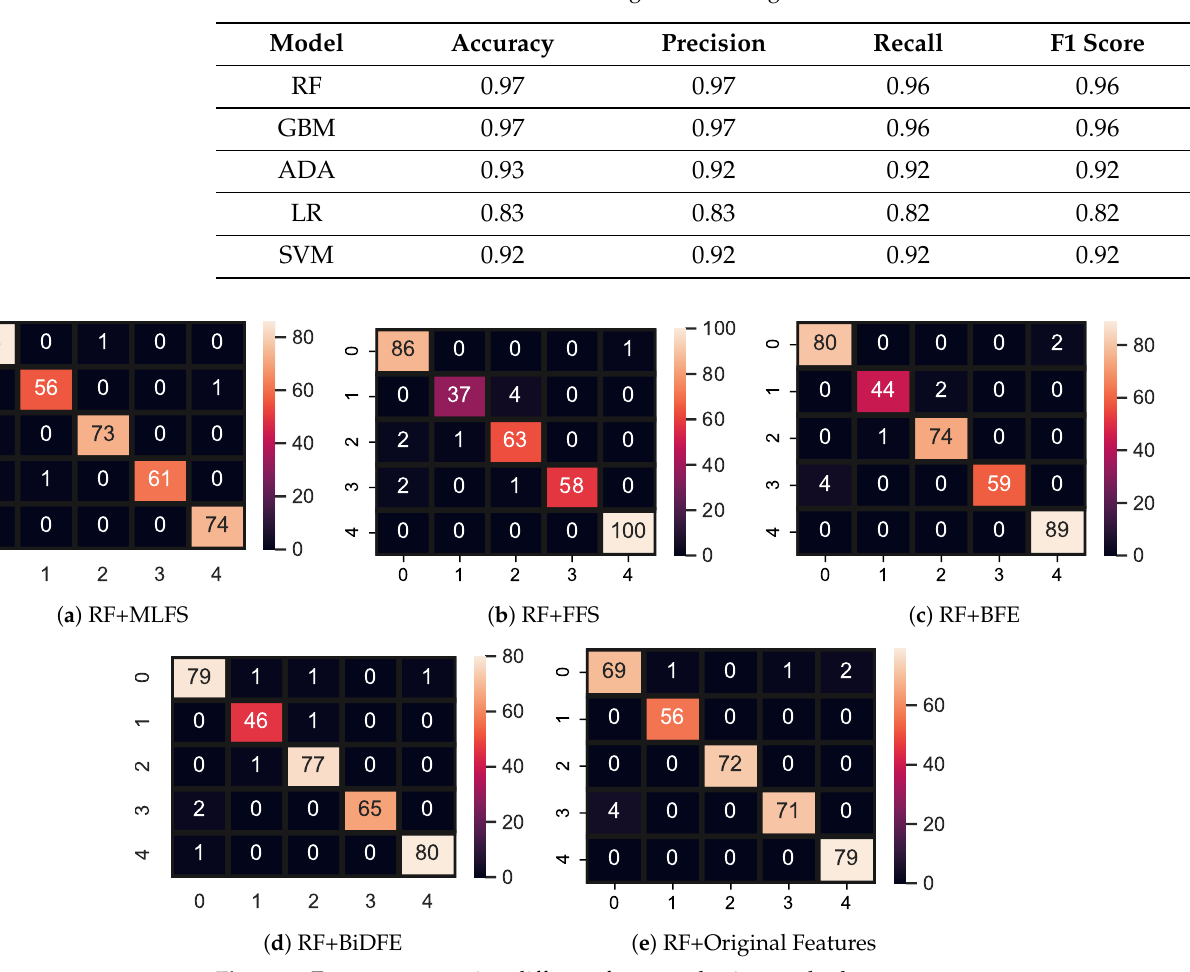
Figure 4. Feature space using different feature selection